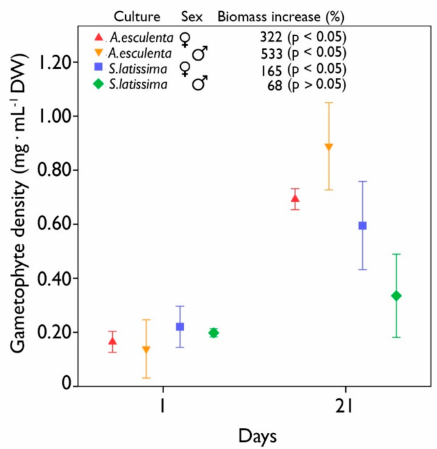
Figure 4. Gametophyte densities of a pool of six clonal male and female cultures of S. latissima and A. esculenta (mg · mL − 1 DW) on day 1 and on day 21. Culture symbols, sex and biomass increase (%) are depicted in the figure. Values are expressed as mean ± SD, n = 3.